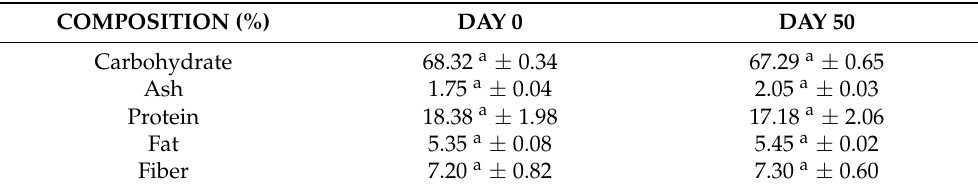
Mean values of standard deviation based on triplicate determination. Means in the same line with different letters are significantly different ( p <